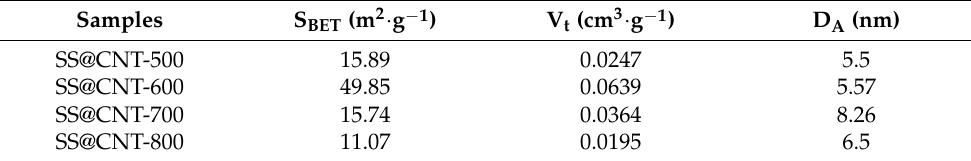
Figure 10a and Table 6 show the TGA result of SS@CNTs under different C 2 H 2